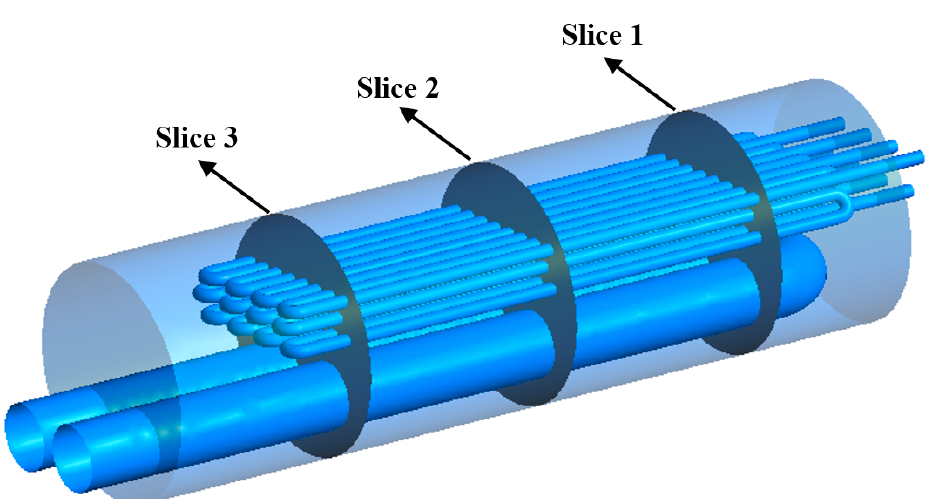
Figure 7. The position of the various slices (three slices) for presentation of the contours.